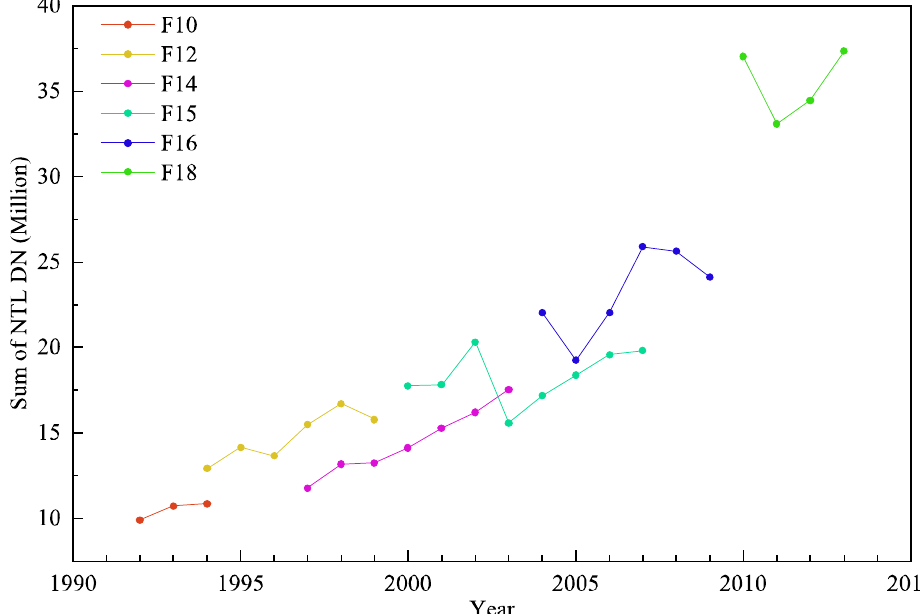
Figure 1. DMSP-OLS long-term series of nighttime light variation curves in China.